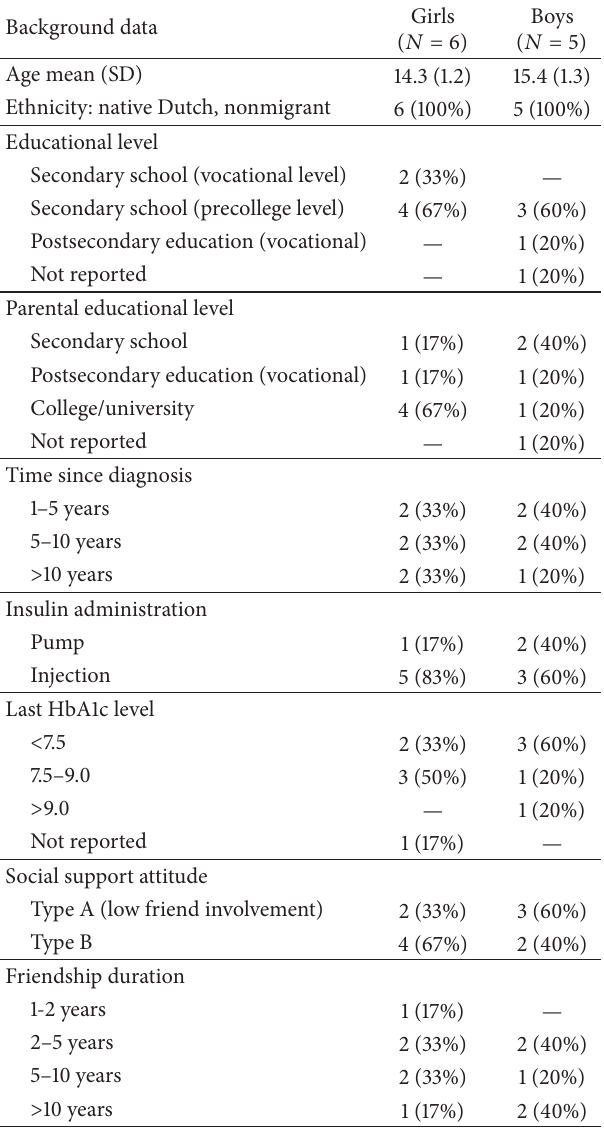
Table 2: Background characteristics of adolescents with diabetes in study